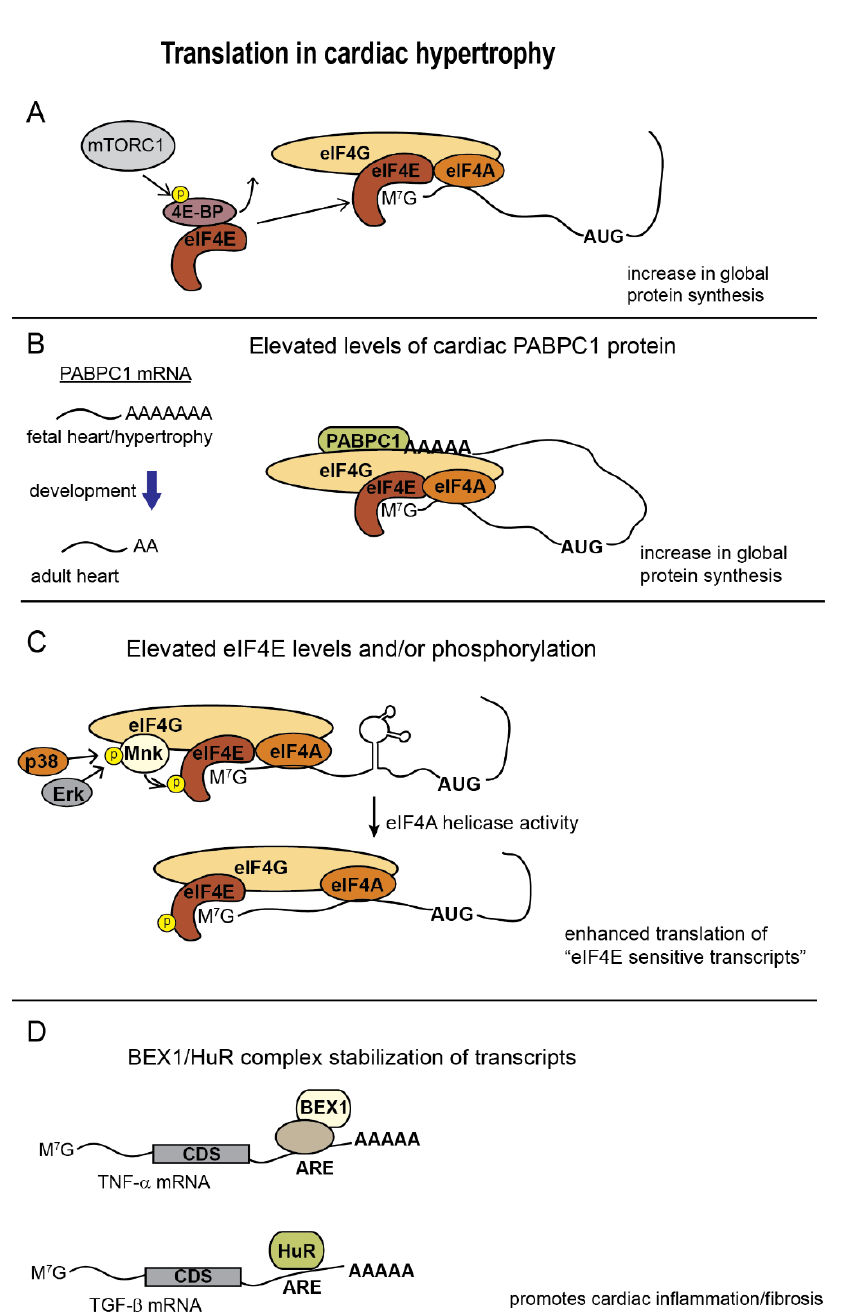
Figure 2. Changes in translation in cardiac tissue undergoing hypertrophy. ( A ), mTORC1 phosphorylation of 4E-BP releases eIF4E to increase global protein synthesis; ( B ), Elongation of PABPC1 poly(A) tail length in response to hypertrophic signaling elevates its translation in the adult heart and allows PABPC1 to enhance global protein synthesis; ( C ), MnK mediated phosphorylation of eIF4E in response to MAPK signaling stimulates eIF4A helicase activity to boost translation of 5’UTRs with complex secondary structure.; ( D ), HuR, and BEX1 (in combination with other proteins) bind AU-rich elements (ARE) during heart failure and promote translation of fibrosis and proinflammatory genes.